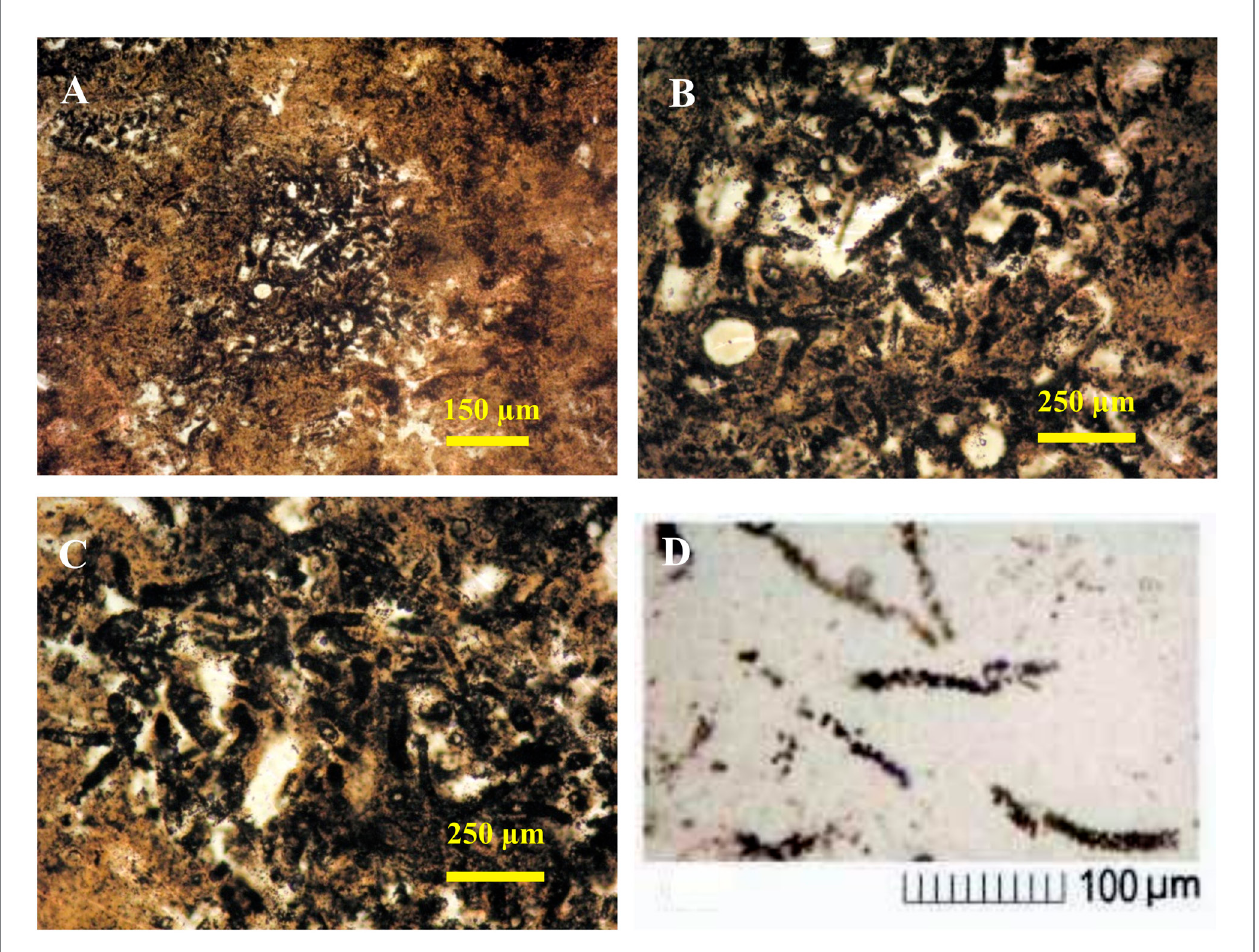
FIGURE 7 – Photomicrographs of sample 2250. A) Photomicrograph in natural light showing opaque and chalcedony-filled bioclast domains in brownish opal. B) Detail of the previous photomicrograph showing circular bioclasts filled by chalcedony; C) Detail of photomicrograph showing elongated opaque-marked bioclasts; D) Photomicrograph of lithic artifact with goethite and maghemite-substituted bioclasts taken from Morgenstein (2006).